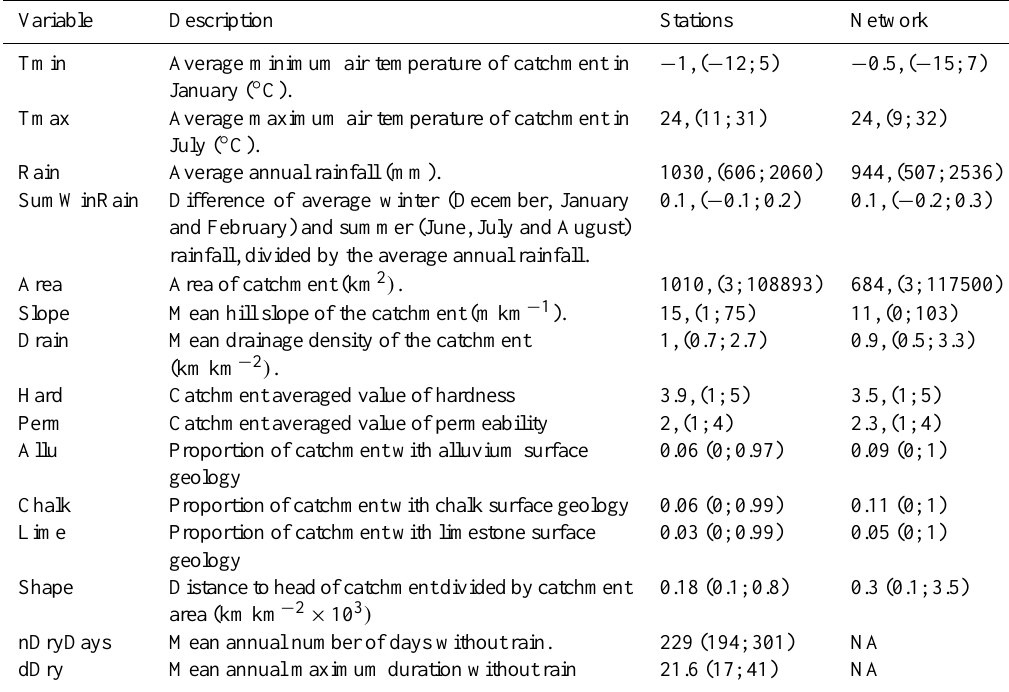
Table 1. Regionalization of patterns of flow intermittence from gauging station records. Variable